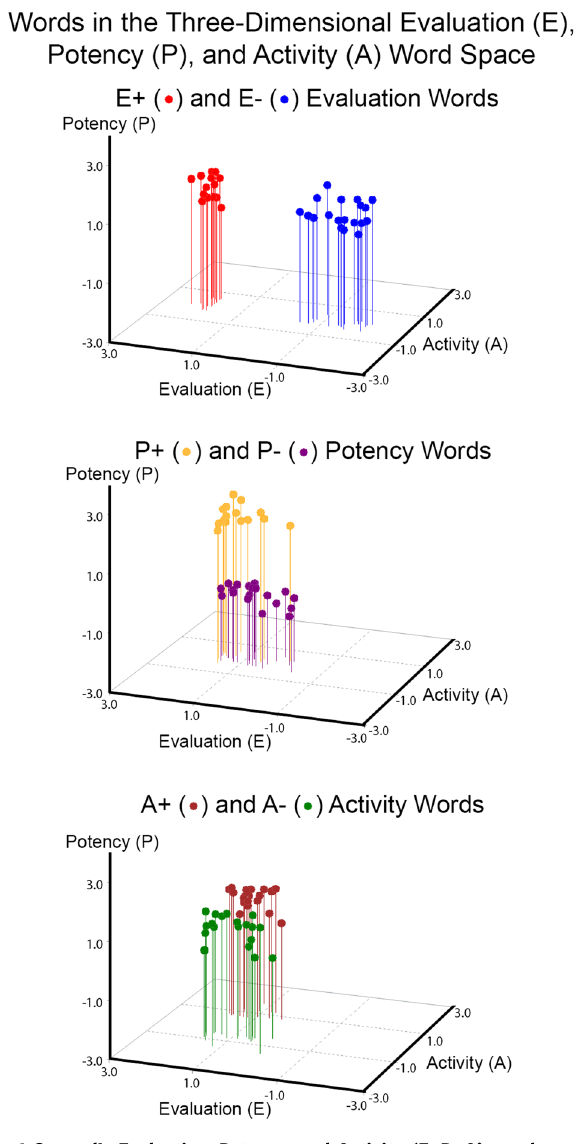
Fig. 1 Osgood ’ s Evaluation, Potency, and Activity (E, P, A) word-space, based on a list of 1551 words compiled by Heise (1971) and Snider and Osgood (1969). Each word exists in this space based on its relationship to these three (E, P, and A) orthogonal dimensions. We selected 120 words that had a rating score strongly either positively or negatively on one dimension while remaining relatively neutral on the other two. This led to the six Word-Classes (20 words each) plotted